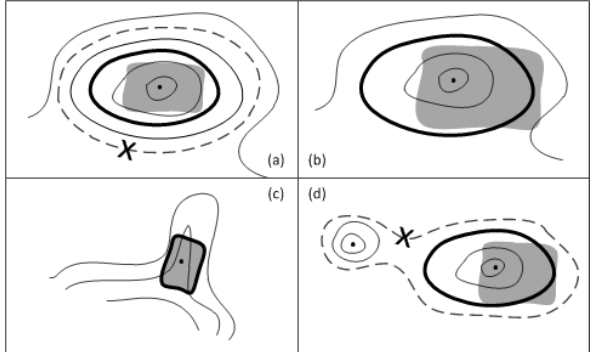
Figure 4. Possible situations in extracting eddy boundary. The contours are represented by the 2 Fig. 4. Possible situations in extracting an eddy boundary. The con- thin solid lines while the eddy boundary is underlined by the thick solid line. Eddies’ core 3 tours are represented by the thin solid lines, while the eddy bound- areas are symbolized by grey polygons. And the dashed lines denote the outermost closed 4 ary is underlined by the thick solid line. Eddy core areas are sym- contours. 5 bolized by grey polygons, and the dashed lines denote the outermost closed